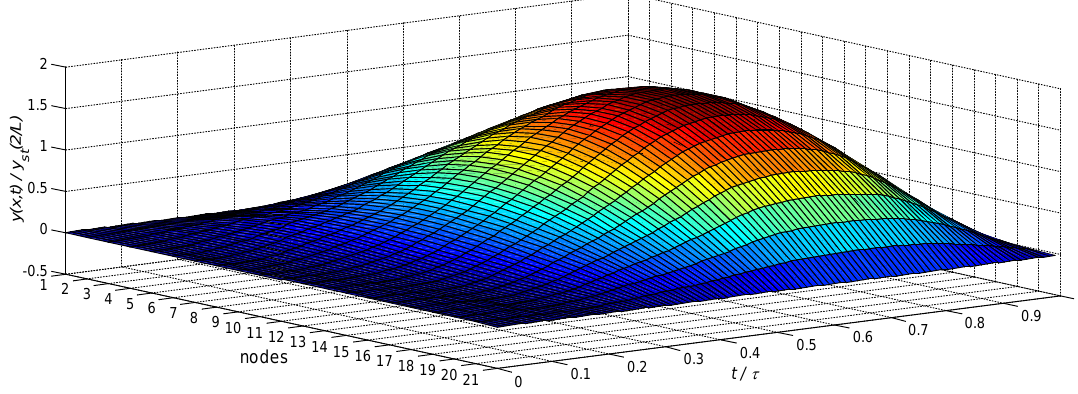
Figure 7. Displacement–time graph at each beam node.